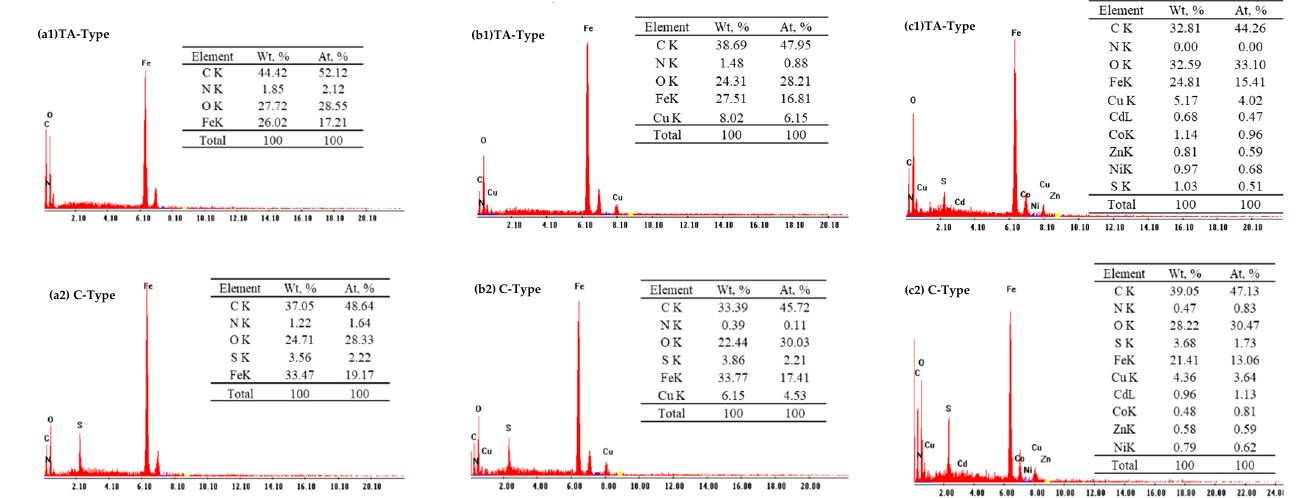
Figure 5. EDX measurements of TA-type and C-type adsorbents before ( a ) and after Cu(II) adsorption from synthetic solution ( b ) and complexed system ( c ).